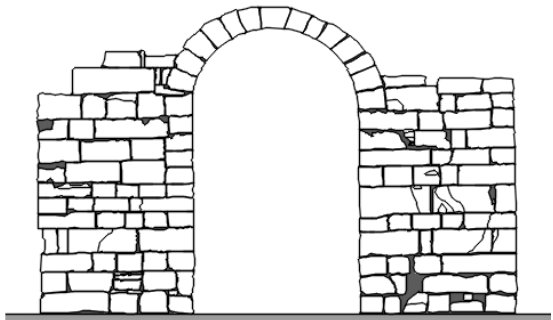
Figure 5. Several tables can be connected by join